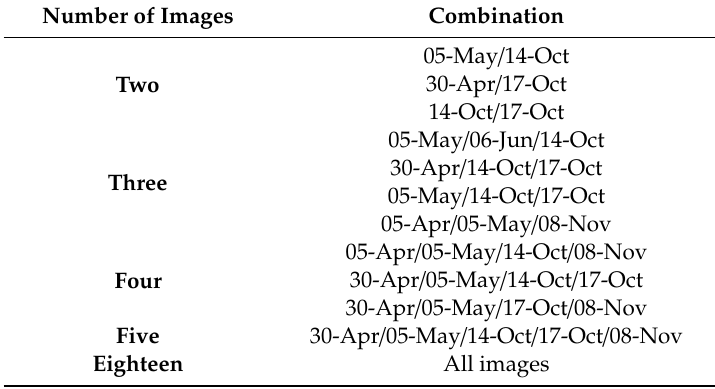
Table 2. Selected combinations for tree species